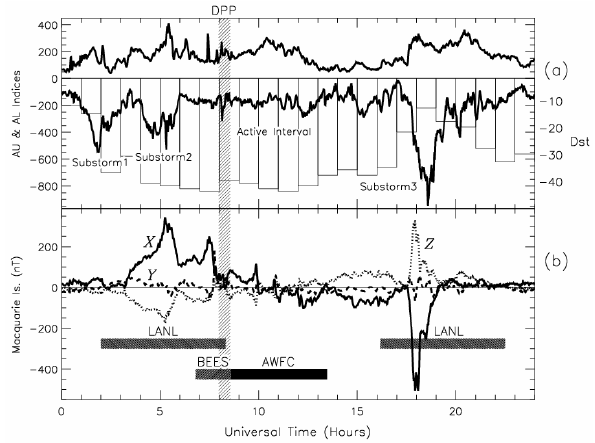
Fig. 2. The trajectory of Cluster 1 satellite in GSM coordinates during ~09 to 12 UT on 7 April 2001. X GSM is positive toward the Sun, Y GSM is positive toward magnetic dusk, and Z GSM is positive toward magnetic north. Cluster 1 locations are highlighted with blue dots at hourly intervals, and the relative locations of the other satellites are exaggerated by a factor of 5.